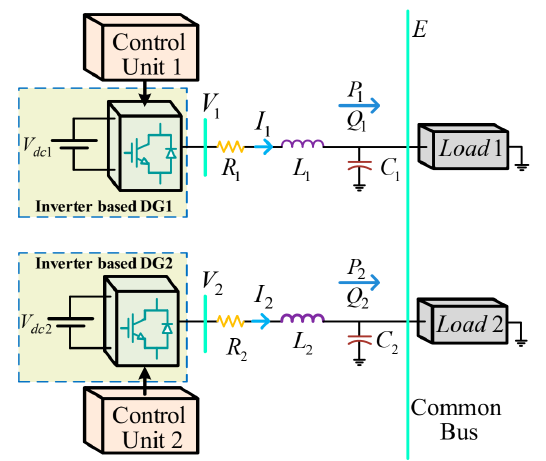
Figure 1. An islanded microgrid with parallel